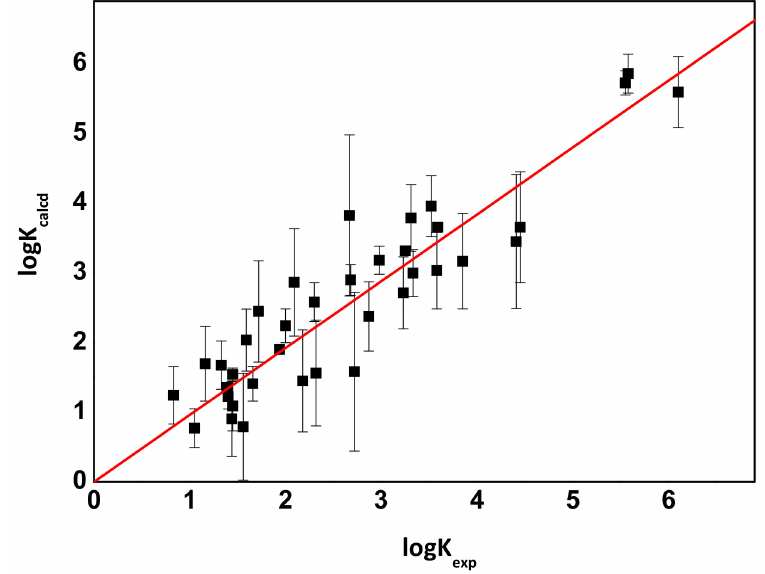
Figure 3. Calculated logK values for As(III) -S, -O-, and -N donor ligand interactions vs. experimental